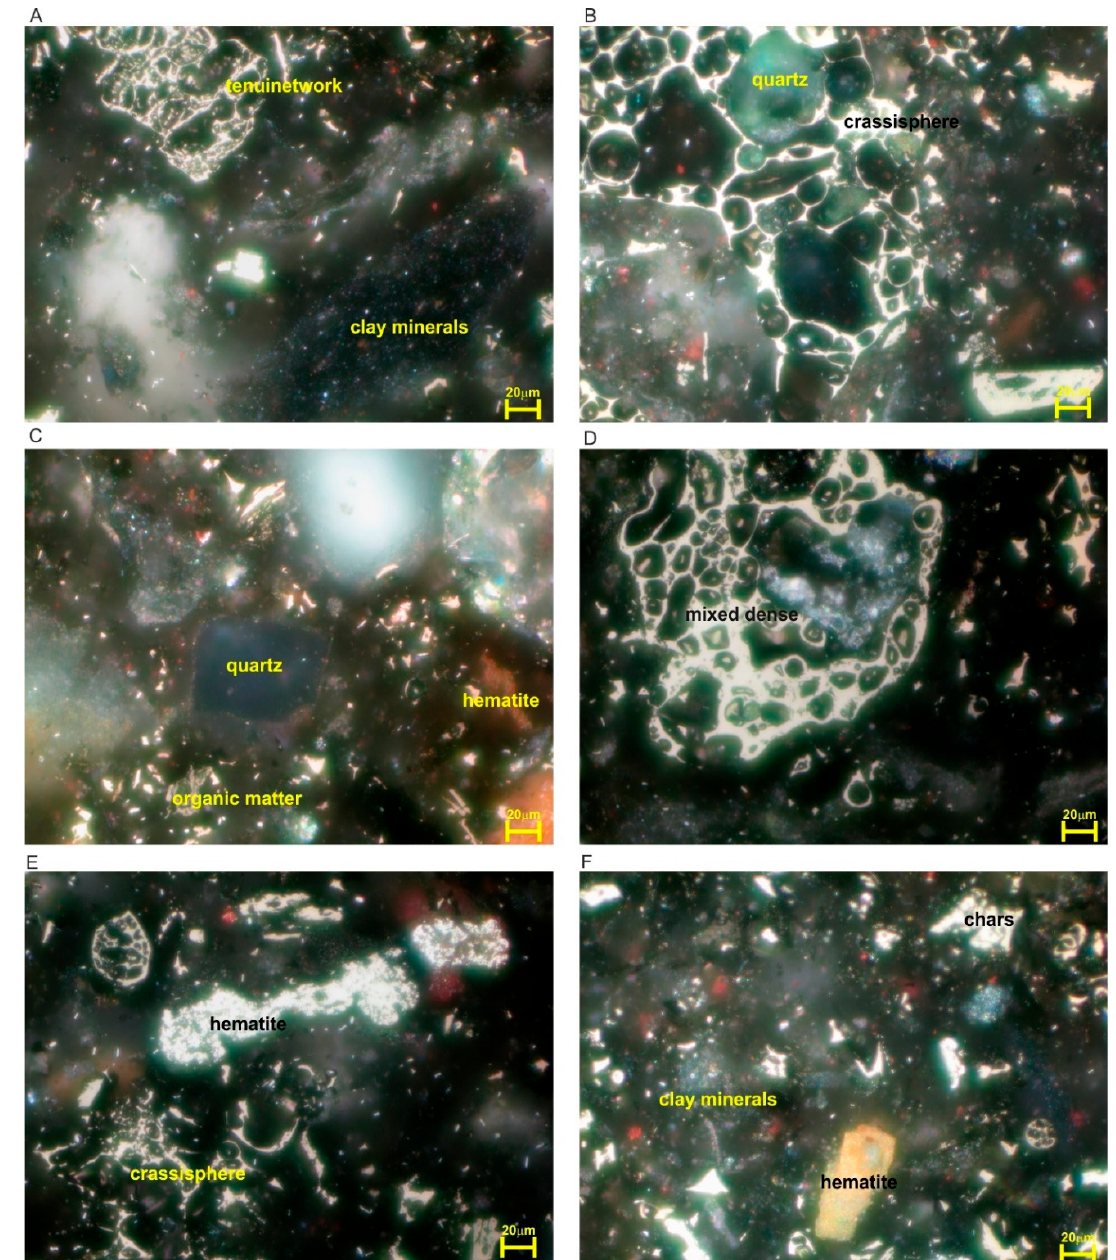
Figure 5. Components of fly ash from the combustion of coal from the Janina deposit: ( A ) Tenuinetwork (bright), clay minerals, ( B ) crassisphere (bright) with quartz, ( C ) quartz (central position), a mixture of minerals and organic particles in the background, ( D ) mixed dense, ( E ) hematite (bright) and crassisphere, ( F ) a mixture of clay minerals, iron oxides, and chars. Reflected light, oil immersion. The observed minerals formed small, di ff erently shaped grains or aggregates. Quartz and clay minerals were the most commonly observed minerals in the sample (Figure 5). The di ff ractogram pattern was dominated by clear quartz peaks (Figure 6), while illite and hematite peaks were slightly less